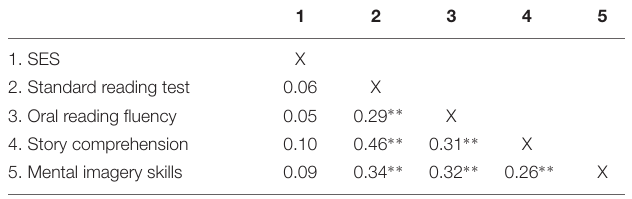
TABLE 1 | Correlations between SES and reading scores.